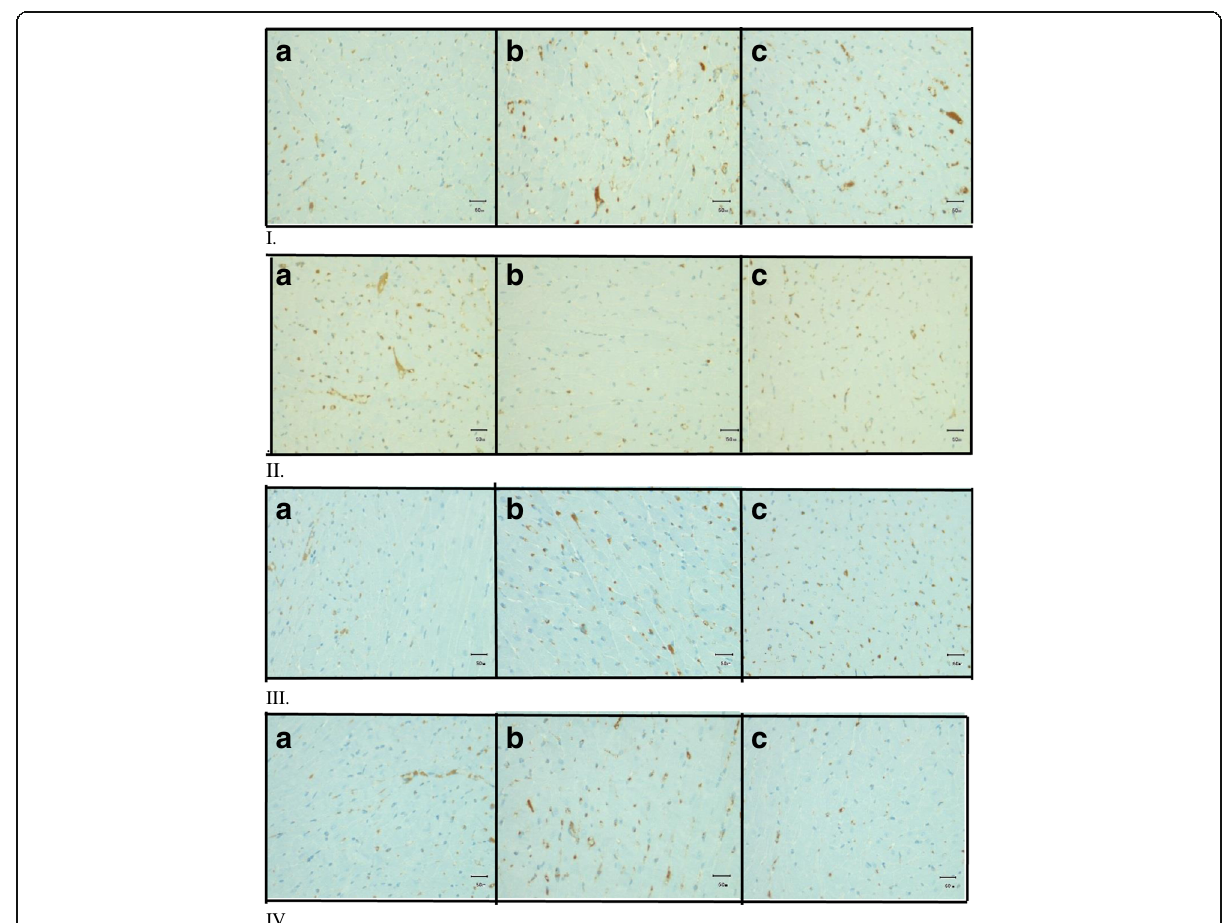
Fig. 1 Photomicrographs illustrated immunohistochemistry study of left ventricular tissue labeled by I . VEGF, II . Von Willebrand III . PECAM-1, IV . NOS-II Antibodies obtained from: a . control, b . nigella sativa fed rats, c . exercise trained